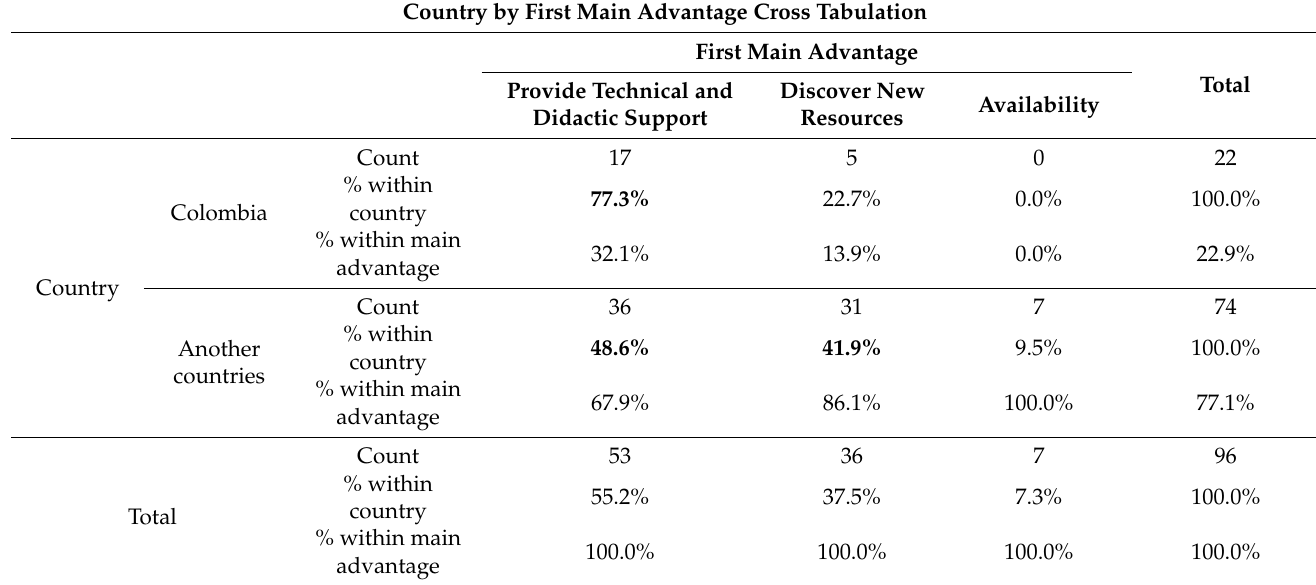
Table 8. Cross tabulation for variables country and first main problem (with percentages by row and column)